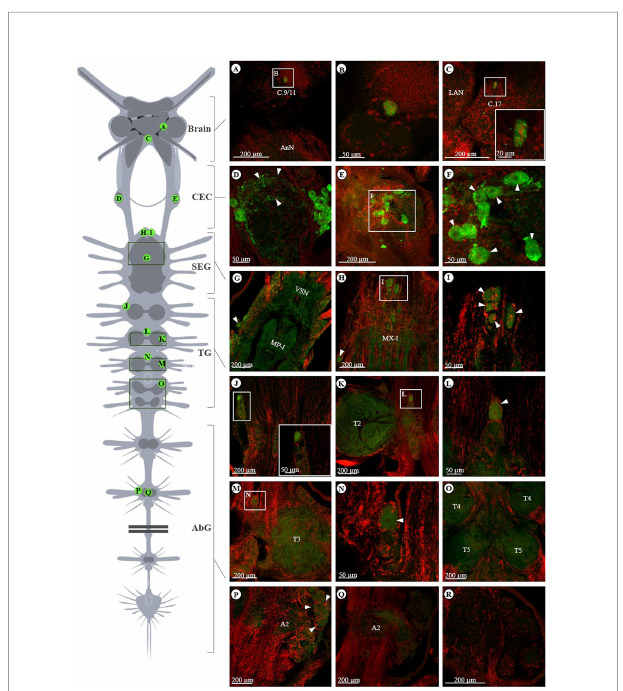
FIGURE 5 | Localization of PemVIH in nervous tissues of subadult female P. monodon . A schematic diagram on left illustrates shrimp ’ s central nervous system including brain, CEC, SEG, TG and AbG. Green circles with letters indicate distribution of PemVIH signals in regions corresponding to Panels (A – R) . Green fl uorescence represents positive PemVIH-ir, whereas red fl uorescence indicates nuclear speci fi c staining of TO-PRO3. (A, B) PemVIH-ir was observed in small neurons in neuronal cluster 9/11 (magni fi ed in B ) and (C) medium size neurons in cluster 17 of the brain. Intense PemVIH-ir was detected in the (D) neuropils (arrow heads) and (E, F) neurons of CEC (magni fi ed in F ). Moderately intense signal of PemVIH-ir was detected in (G – I) neurons (arrowheads) and (G, H) neuropils of SEG and (J – O) TG. (P, Q) A weak signal of PemVIH-ir was observed in AbG. (R) The negative control where the representative of CEC tissue incubated